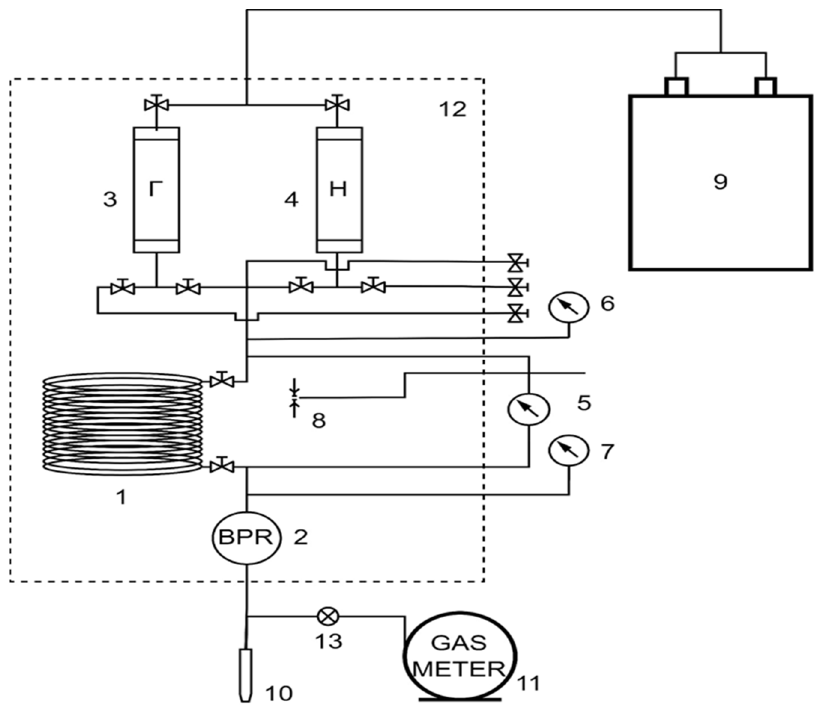
Figure 1. Slim tube unit: 1—slim tube; 2—back pressure regulator (BPR); 3—injected gas sample; 4—oil sample; 5—differential manometer; 6—inlet manometer; 7—outlet manometer; 8—thermocouple; 9—plunger pump; 10—oil burette; 11—gas meter; 12—constant temperature oven; 13—gas sample line.